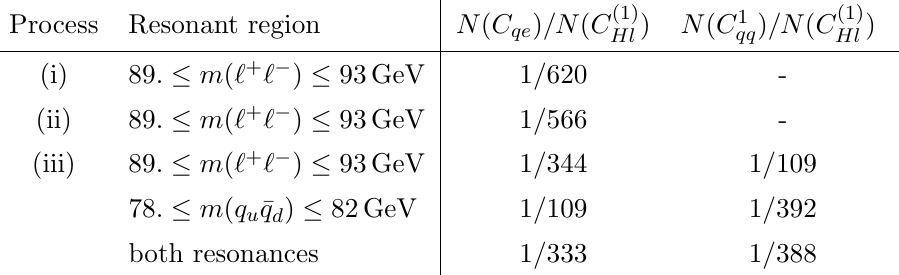
interference of non-pole ( C qe ; C (1) qq ) L d =6 1 = 220(250) for B = Z ( W T (cid:25)